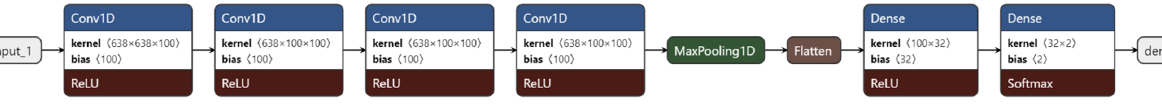
Figure 1. Implemented